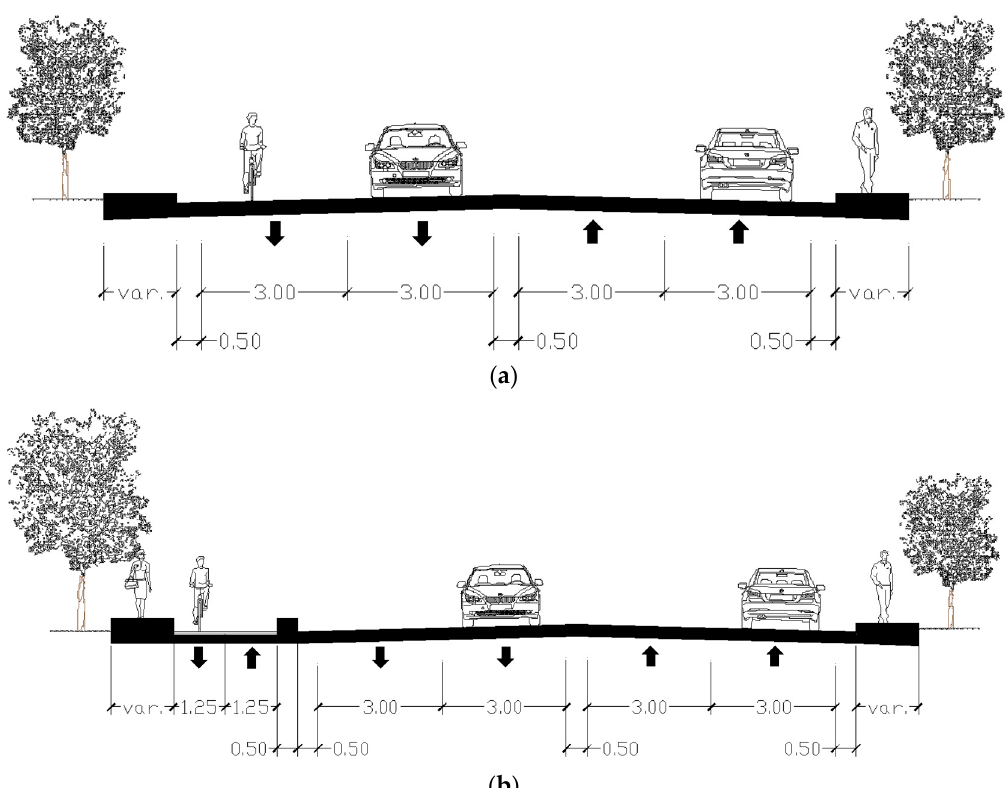
Figure 2. Cross sections of the examined approaches (unit of measurement—m). ( a ) Cross section of Figure 1a; and ( b ) cross section of Figure 1b.